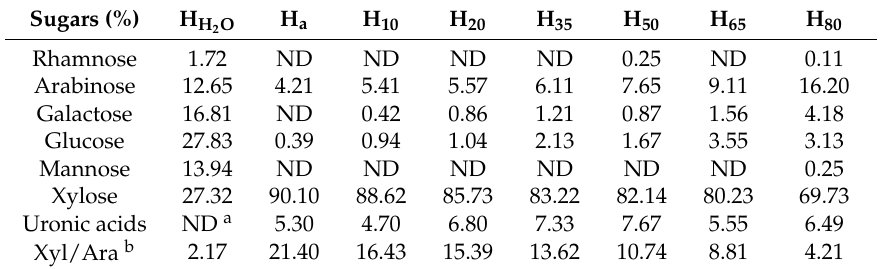
Table 1. Contents of neutral sugars and uronic acids (relative %, W / W ) in the isolated hemicellulosic